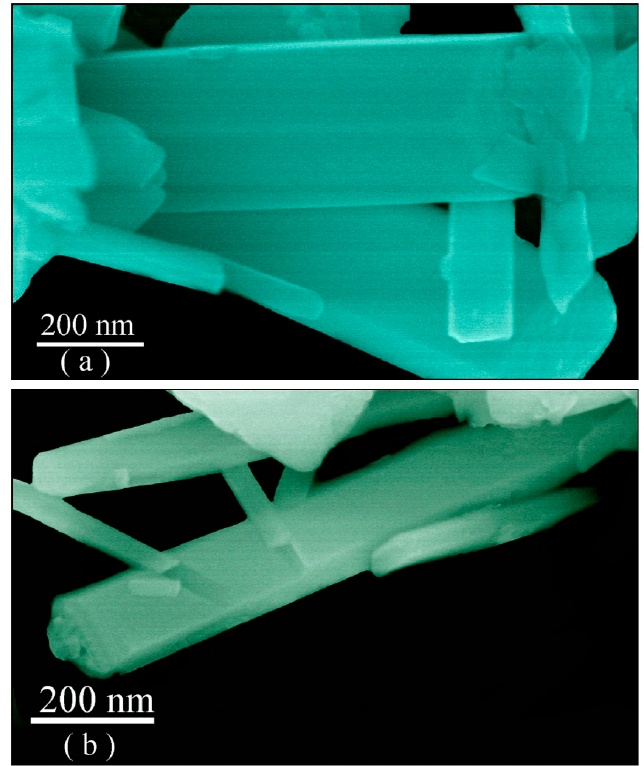
Figure 3. High-resolution SEM micrographs of ZnWO 4 nanoplates: ( a ) Two large nanolates with two small nanoplates; ( b ) One large nanolate with a few small nanoplates.